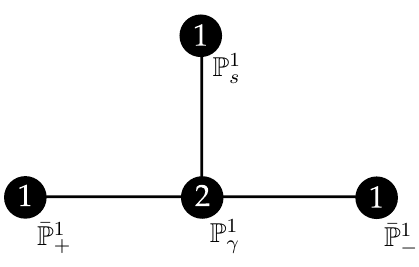
Figure 3 . The structure of the codimension two singular (cid:12)ber over the locus b = c 2 = 0, demon- strating the intersection pattern of the curves in (3.18); the numbers on each node indicate the multiplicity. It is a non-Kodaira singular (cid:12)ber which is a contraction of the I (cid:3) one multiplicity one node is